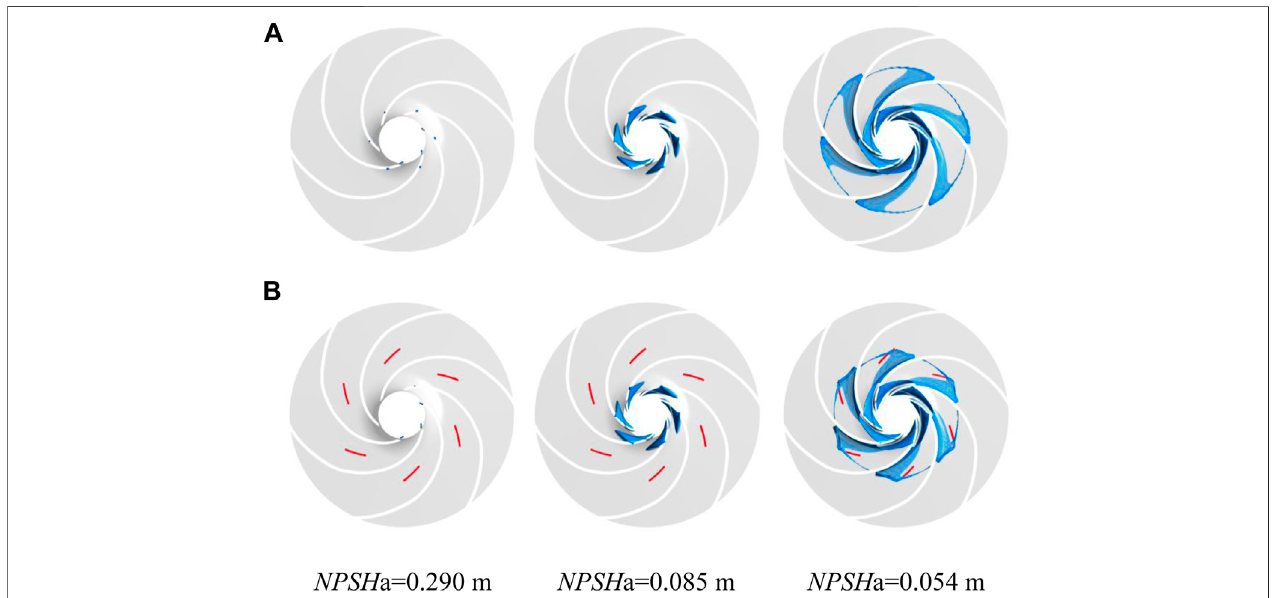
FIGURE 7 | Vapor volume fraction distribution of the impeller: (A) original impeller and (B) B3 impeller.